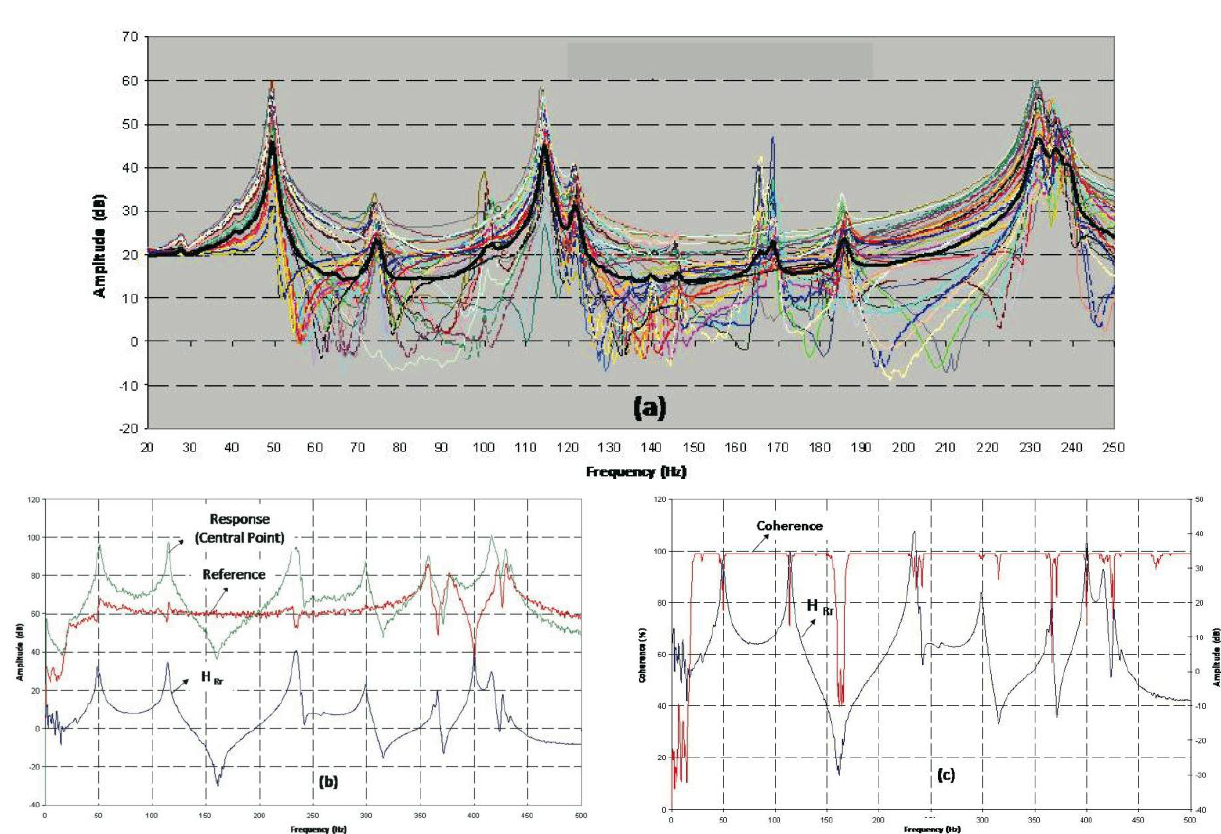
Figure 4. ( a ) Naked Metal Sheet Transmissibility ( b ) Response and Reference Autospectrum ( c ) Coherence and Transmissibility (Central point and